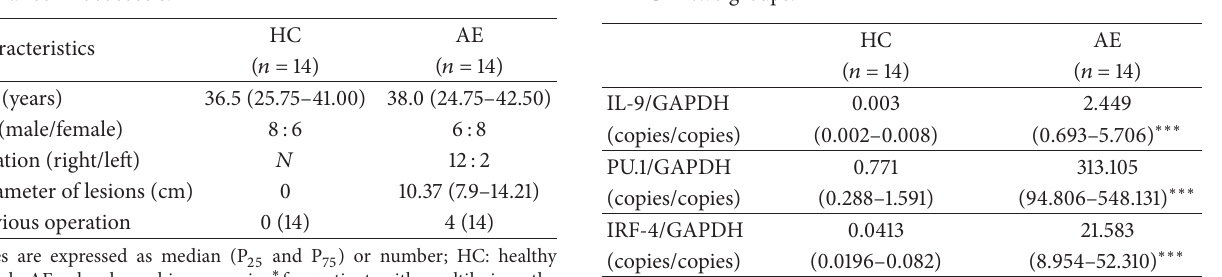
Table 3: The expression levels of IL-9, PU.1, and IRF-4 mRNA in PBMC in two groups.